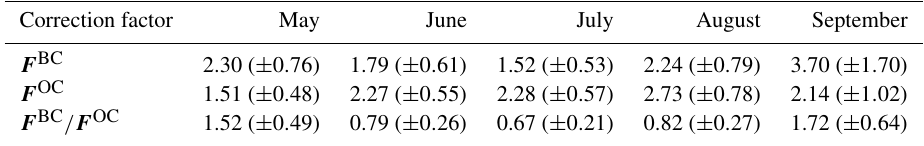
Table 2. Optimal monthly estimates of the correction factors, F BC and F OC , for the OC and BC emission rates (see Eq. 2), along with the ratios of optimal estimates for F BC and F OC . The values in brackets indicate the 90% confidence